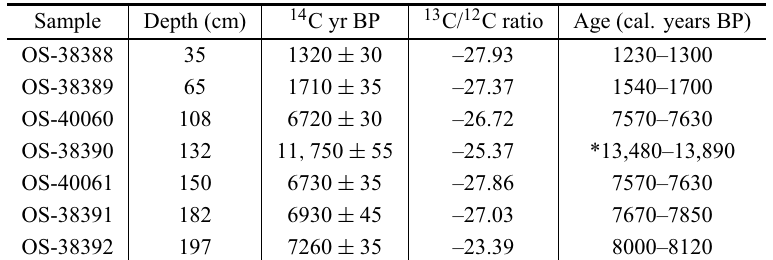
Radiocarbon dates from Lake Tapera.